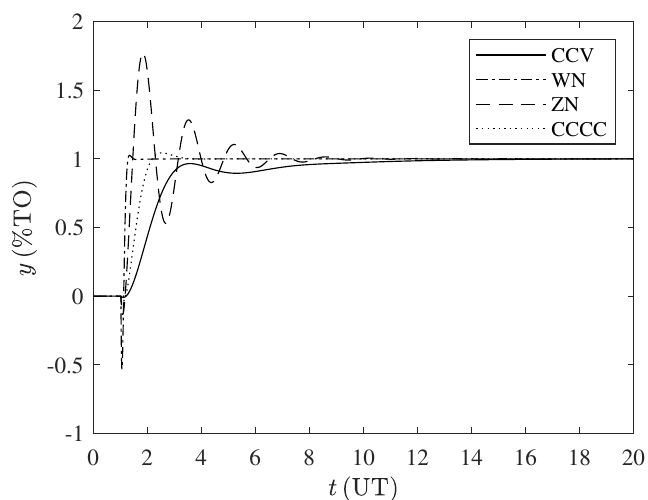
Figure A10. Time response set-point tracking for the set P 6 . %TO: percentage of transmitter output, UT: units of